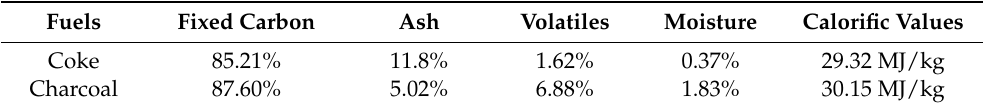
Table 2. Fuel performance